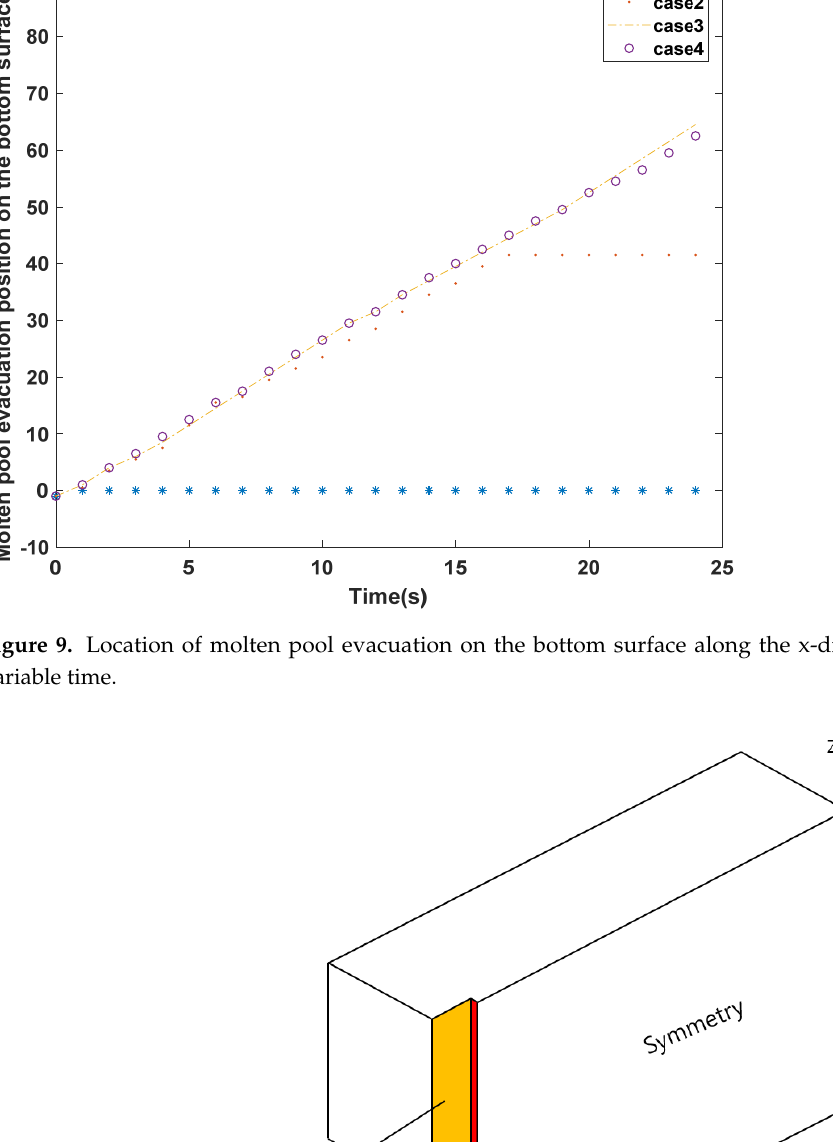
Figure 8. Molten pool behavior and evacuation captured by the high-speed camera in case 4 at ( a ) t: